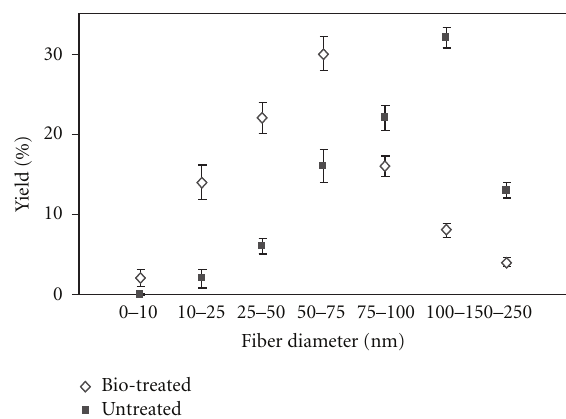
Figure 1: E ff ect of OS1 fungal treatments on number average diameter distribution of nanofibres after PFI refining for a 4-day treatment.